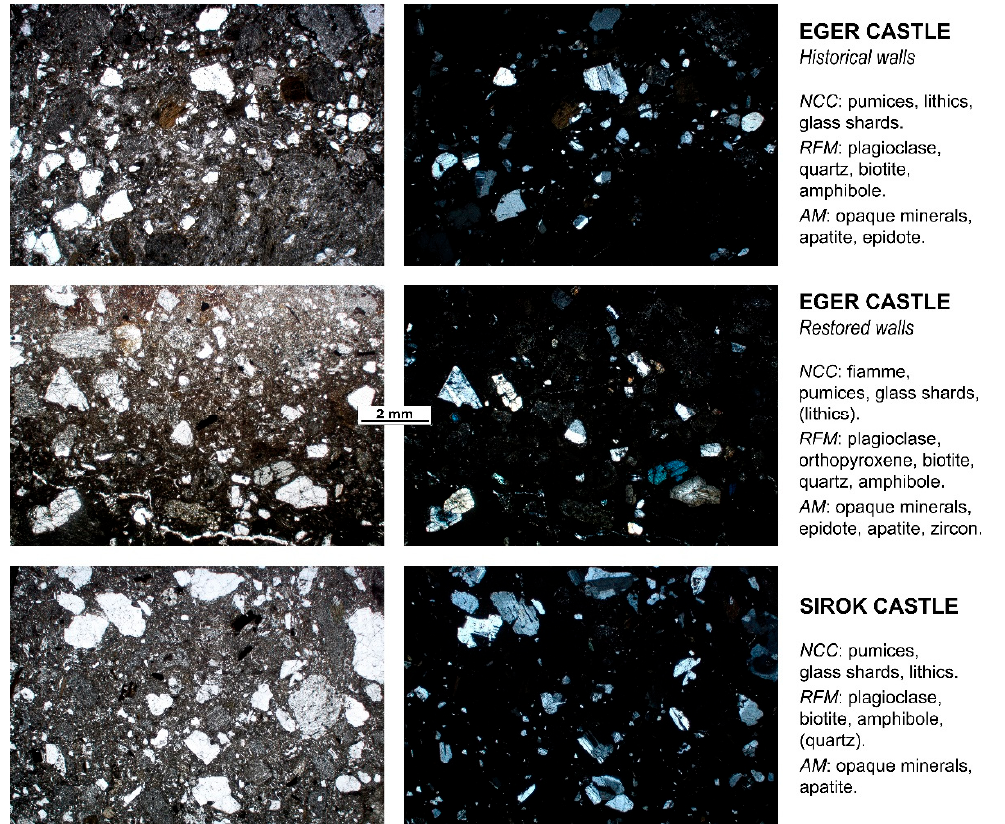
Table 2. Semi-quantitative composition of the studied tuffs calculated from the relevant XRD patterns considering the major mineral phases (Ab = albite; Act = actinolite; Bt = biotite; Crs = cristobalite; mHal = meta-halloysite; Mnt = montmorillonite; Qz = quartz).